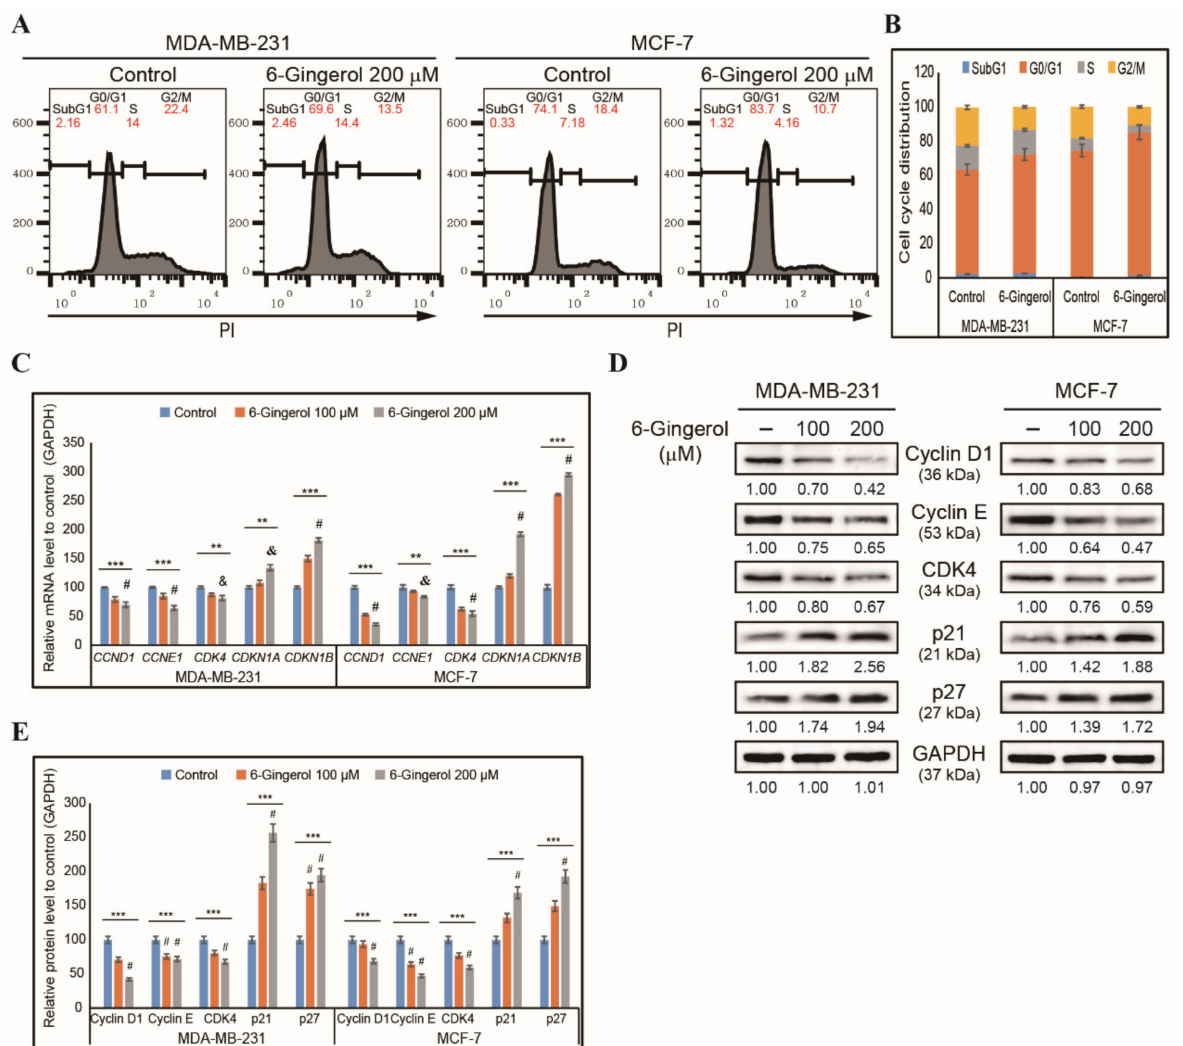
Figure 3. 6-Gingerol induces cell cycle arrest. ( A ) Flow cytometry analysis using PI staining showing cell cycle distribution in MDA-MB-231 and MCF-7 cells after 48 h treatment with 6-gingerol. ( B ) Graphical representation of cell cycle distribution showing G0/G1 arrest by 6-gingerol in breast cancer cells. ( C ) RT-qPCR showing expression of cell cycle checkpoint genes. The representative expressions of CCND1 , CCNE1 , CDK4 , CDKN1A , and CDKN1B mRNA are shown; Cp values were normalized to GAPDH mRNA. Controls are set to 100. ** p < 0.01 and *** p < 0.001 (ANOVA test), & p < 0.01 vs. control, and # p < 0.001 vs. control. ( D ) Western blotting of MDA-MB-231 and MCF-7 cells after 48 h treatment with 100 and 200 µ M of 6-gingerol showing the expression of cyclin D1, cyclin E, CDK4, p21, and p27. ( E ) Representative protein expression was determined by densitometry and normalized to GAPDH. Controls are set to 100. Data were confirmed after repeating the experiment three times. *** p < 0.001 (ANOVA test). # p < 0.001 vs.